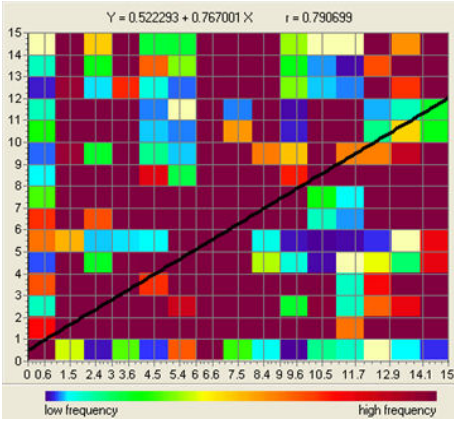
Figure 10. Spatial relationship between predicted LULC of 2007 (using 3x3 contiguity filter) and LULC derived from LISS III image of 2007 (references image)